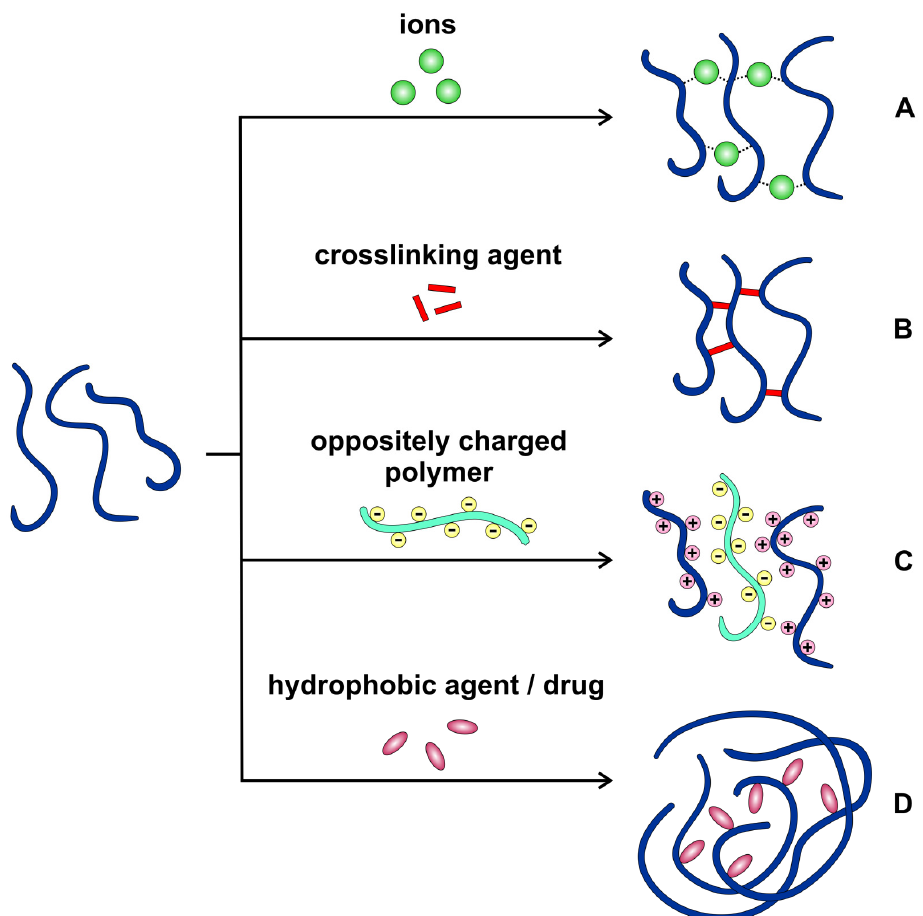
Figure 2. Mechanisms of gum-based micro- and nanoparticle formation: ( A ) ionotropic gelation, ( B ) covalent crosslinking, ( C ) polyelectrolyte complexation, and ( D ) drug or hydrophobic agent/polymer conjugation with self-assembly [31,38,39].